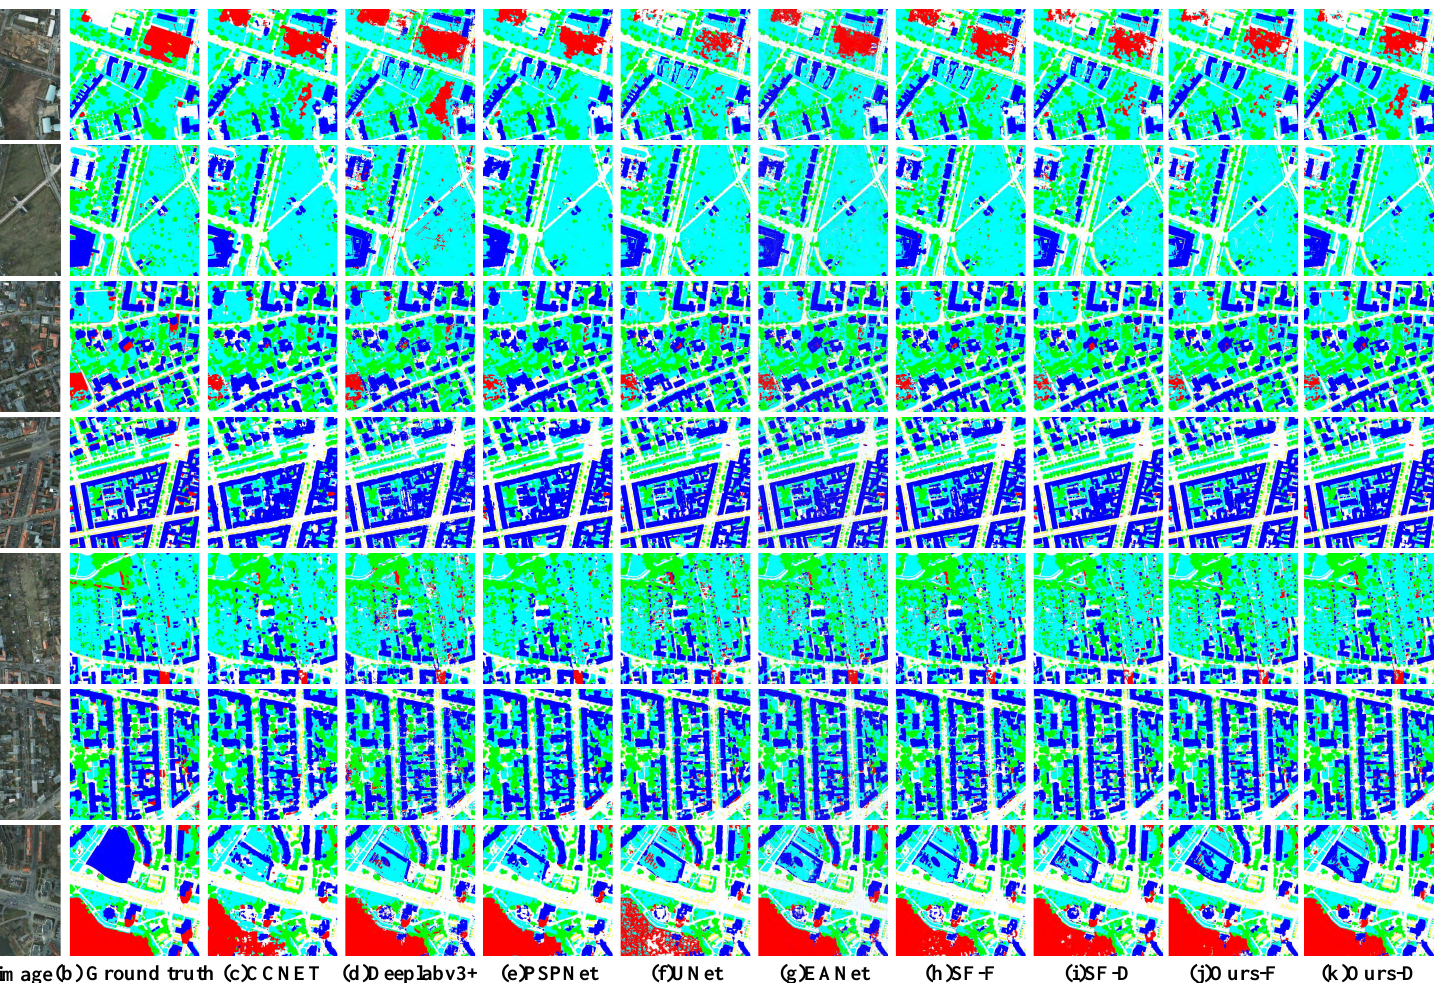
Figure 11. Visualization of all models on Potsdam dataset. ( a ) Ground truth. ( b ) Results of CCNet. ( c ) Results of Deeplabv3+. ( d ) Results of PSPNet. ( e ) Results of UNet. ( f ) Results of EANet. ( g ) Results of SFNet with FCN. ( h ) Results of SFNet with Deeplab. ( i ) Results of our method with FCN. ( j ) Results of our method with